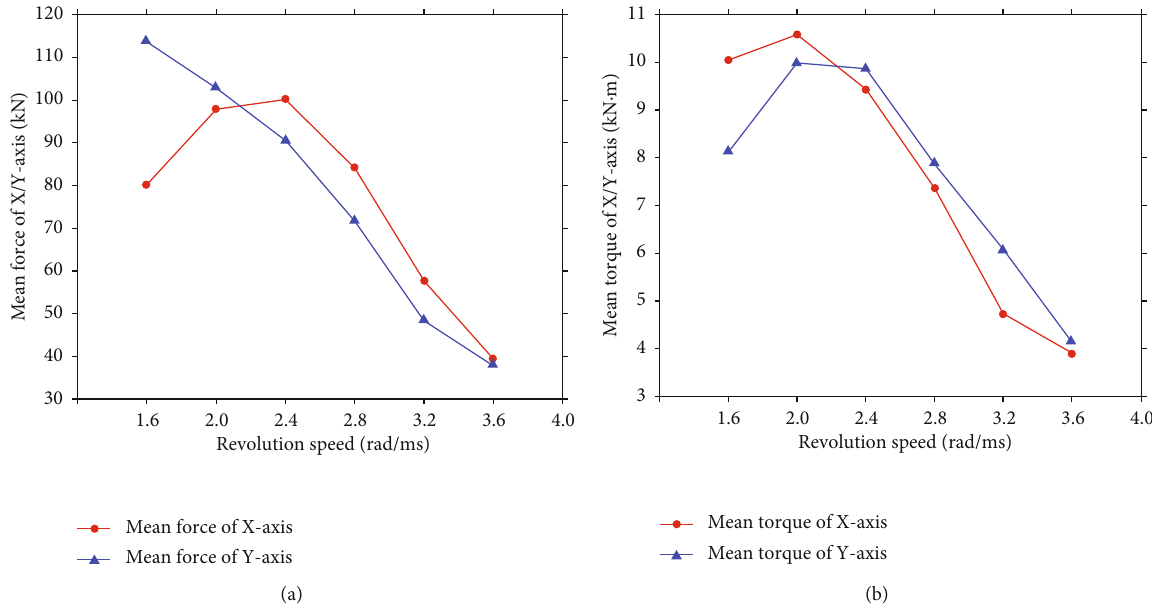
Figure 8: The impact of revolution speeds on mean force and torque on the PDC teeth of bionic blade. (a) Mean force. (b) Mean torque.